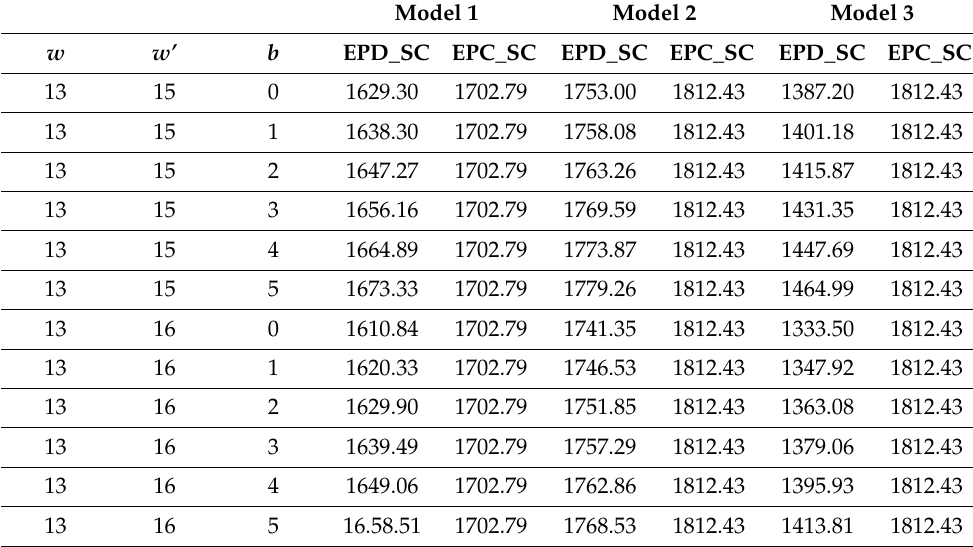
Table 1. The supply chain’s expected total profits with different b , w = 13, 14, and I 0 =